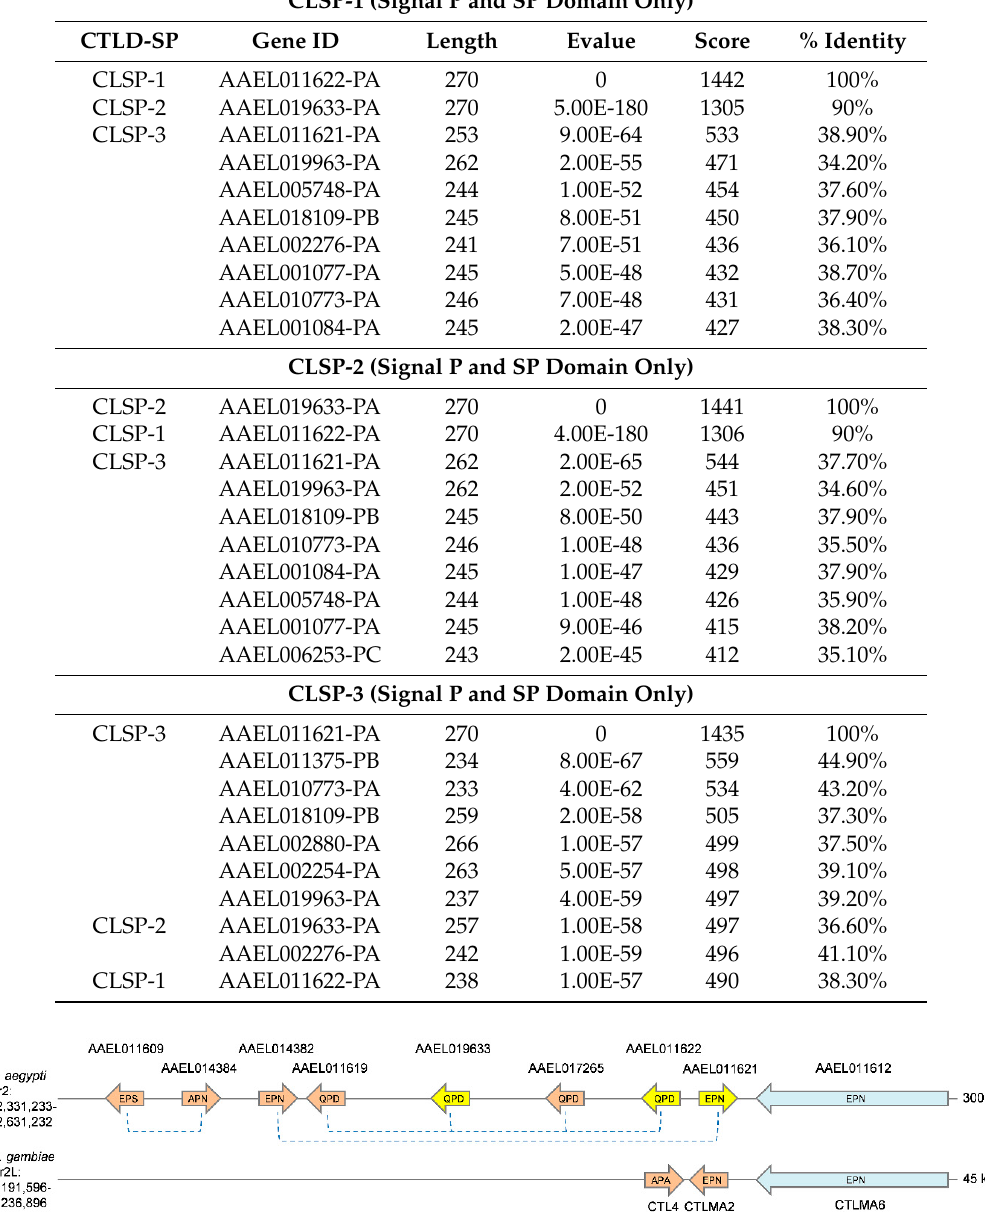
Figure 4. Expansion of CTLD-S and CTLD-SP genes in A. aegypti . Syntenic regions of the A. aegypti and A. gambiae genomes containing related clusters of CTLDcps. Genes encoding CTLD-S (orange), CTLD-SP (yellow), and CTLD-E (blue) are indicated (not to scale). Dotted lines indicated A. aegypti CTLDs that clustered together in Figure 3. Three letter codes indicate the residues present in the putative sugar-binding region of each CTLD.